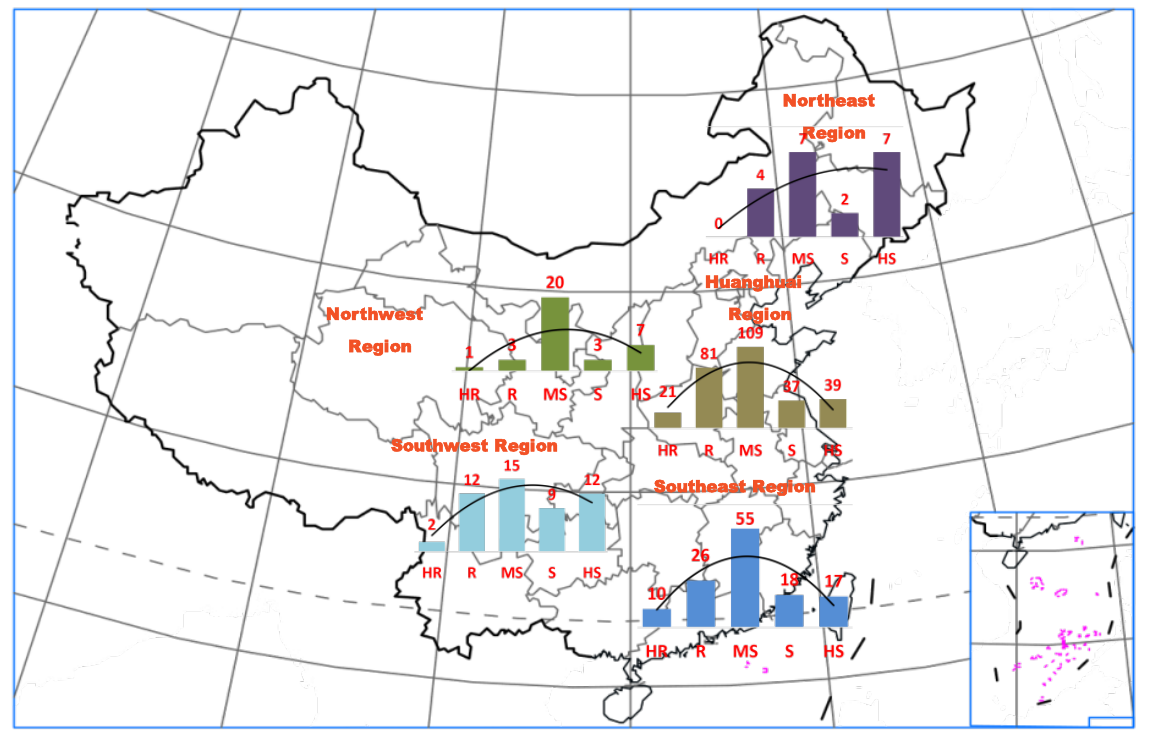
Figure 8. Geographic distribution of the soybean germplasm resources and the levels of anthracnose resistance. HR, highly resistant; R, resistant; MS, moderately susceptible; S, susceptible; HS, highly susceptible.